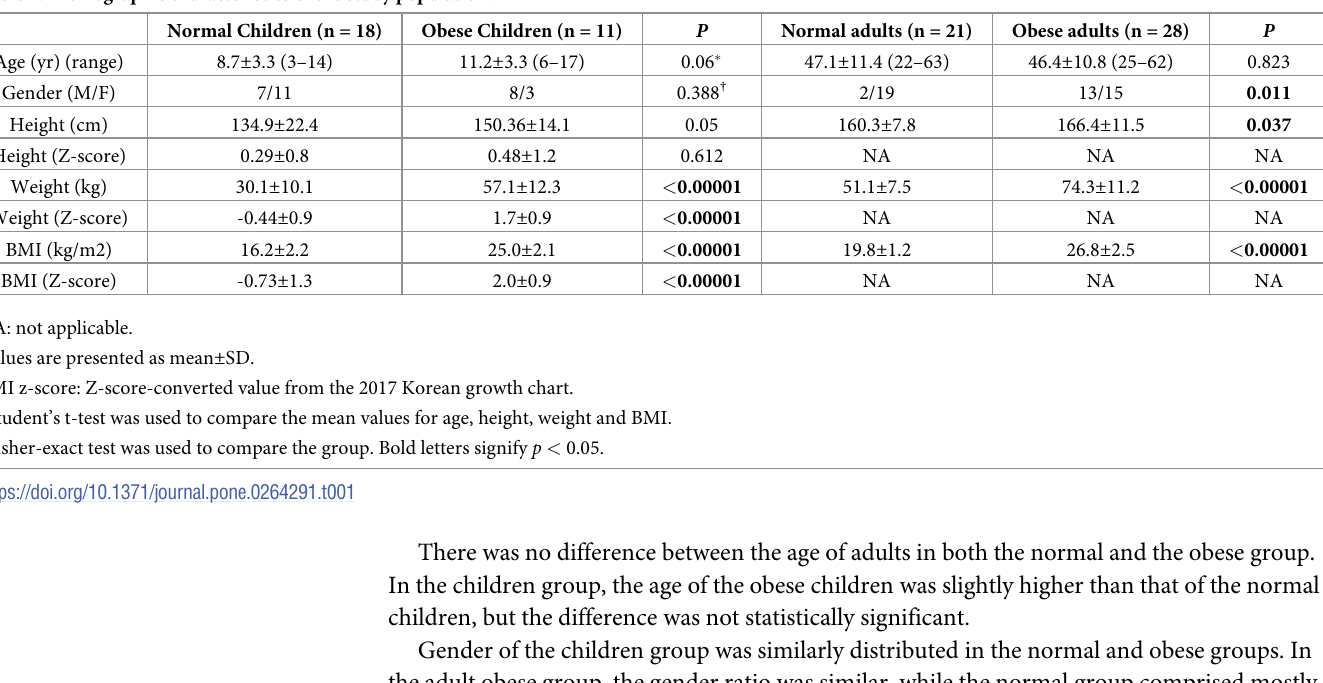
Table 1. Demographic characteristics of the study